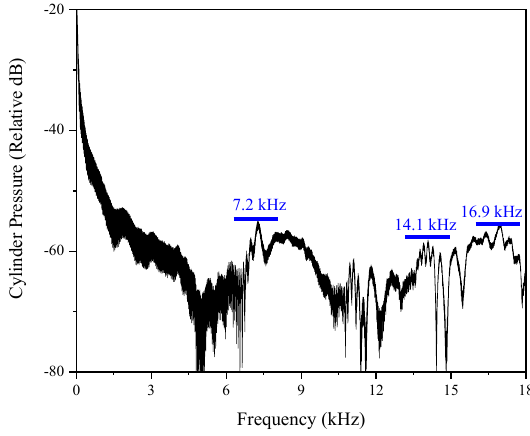
Figure 12. FFT analysis of in-cylinder pressure at P c = 2.14 MPa, FIP = 50 MPa, ∆ t = 2.0 ms.